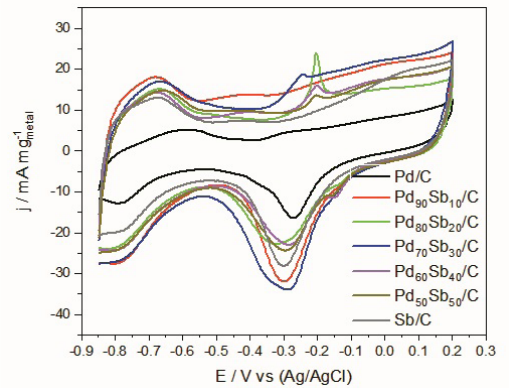
Figure 3. Cyclic voltammetry of PdSb materials in KOH 1 mol.L -1 (v= 10 mV.s -1